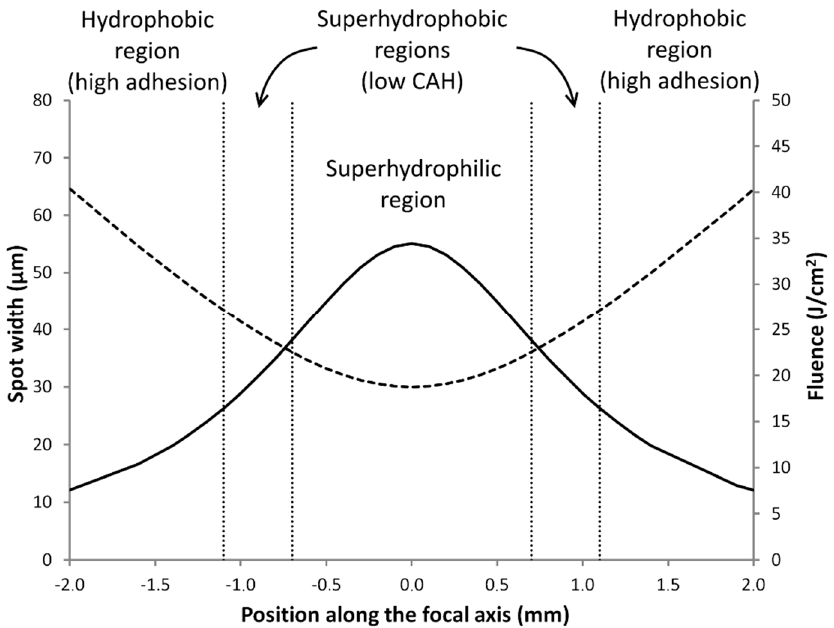
Figure 5. Different wetting behaviors in terms of the sample position along the focal axis compared with the spot width (dashed line, units on the left axis) and fluence (continuous line, units on the right axis) of the green laser.